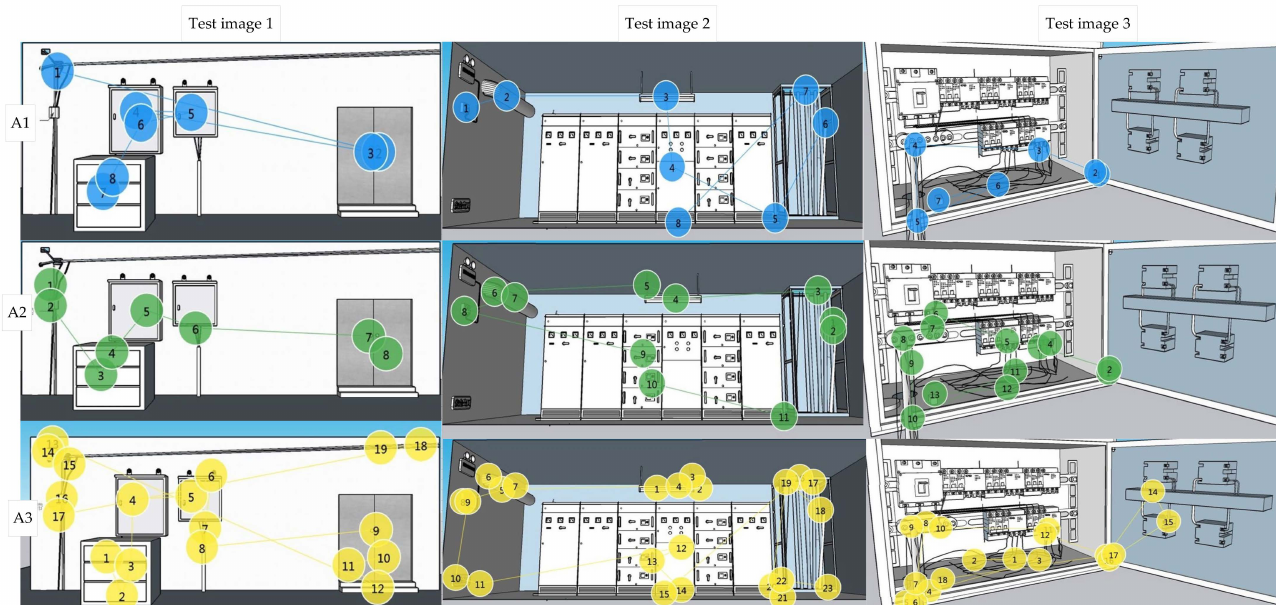
Figure 10. The typical scanning path of workers in three test images. A1 represents A1 group (electrical safety experts), A2 represents A2 group (skilled workers with at least five years of work experience), A3 represents A3 group (employees with less than a year on the